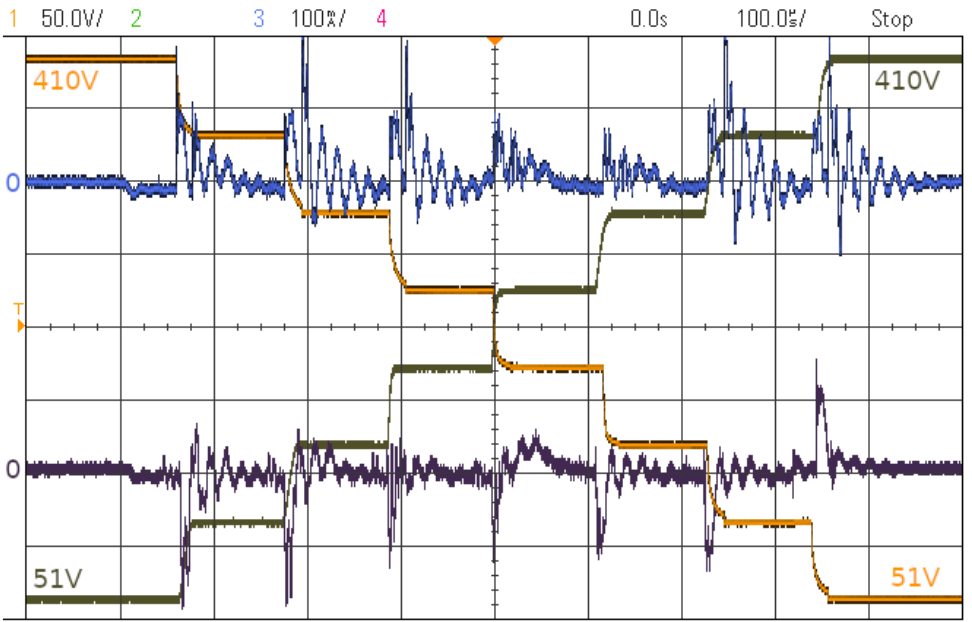
Figure 4. Voltage and current waveforms during battery reconfiguration using oscilloscope’s memory function. Orange curve shows battery pack voltage during transition from series to parallel configu- ration. Green curves show pack’s voltage during transition from parallel to series configuration, both with a smooth transition and without ringing. Blue and purple curves show inrush current in lowest 48V battery, observed to be in 100mA